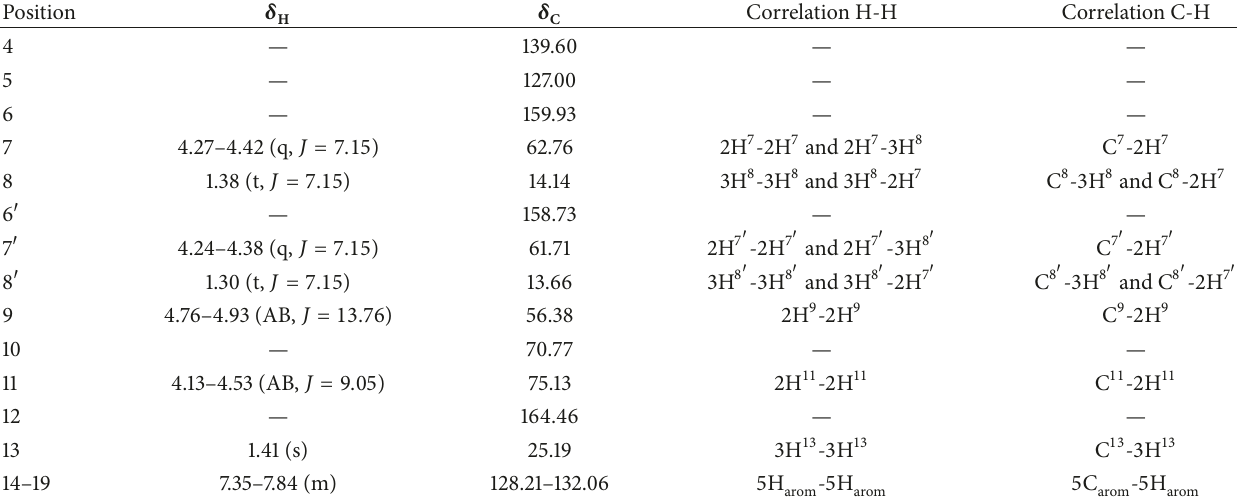
Table 1: 1 H (300.13MHz) and 13 C (75.47 MHz) NMR spectral data for compound 2 in CDCl 3 , including results obtained by homonuclear 2D shift-correlated and heteronuclear 2D shift-correlated HSQC ( 1 𝐽 CH ). Chemical shifts ( 𝛿 in ppm) and coupling constants ( 𝐽 in Hz). The definite assignment of the chemical shifts of protons and carbons of compound 2